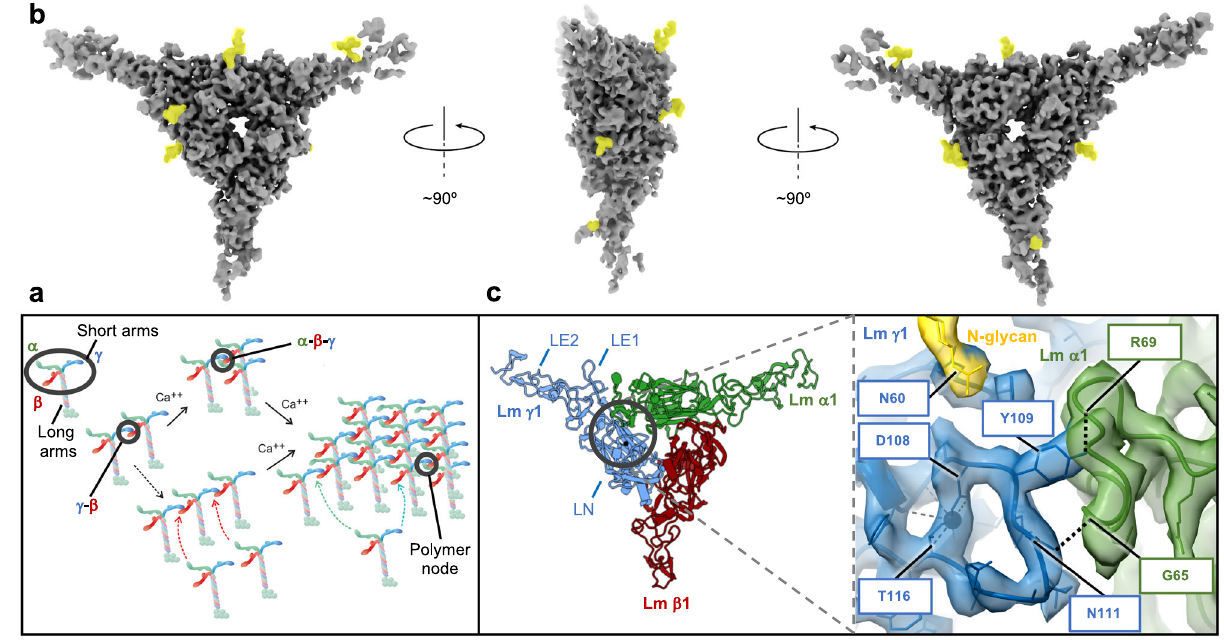
Fig.1|Cryo-EMstructureandmechanismsofLmpolymerization.a Amodelfor Lm assembly and polymerization. Calcium independent formation of β 1- γ 1 dimers is followed by a calcium dependent association of α 1, and the extension of Lm matrix.Lmshortandlongarms,andoneofthetrimericLmpolymernodesformed byinteractingshortarmsfromLm α 1, β 1and γ 1arehighlightedinblack. b Different views ofthe cryo-EMmap. The N-glycans are colored in yellow. c Structural details